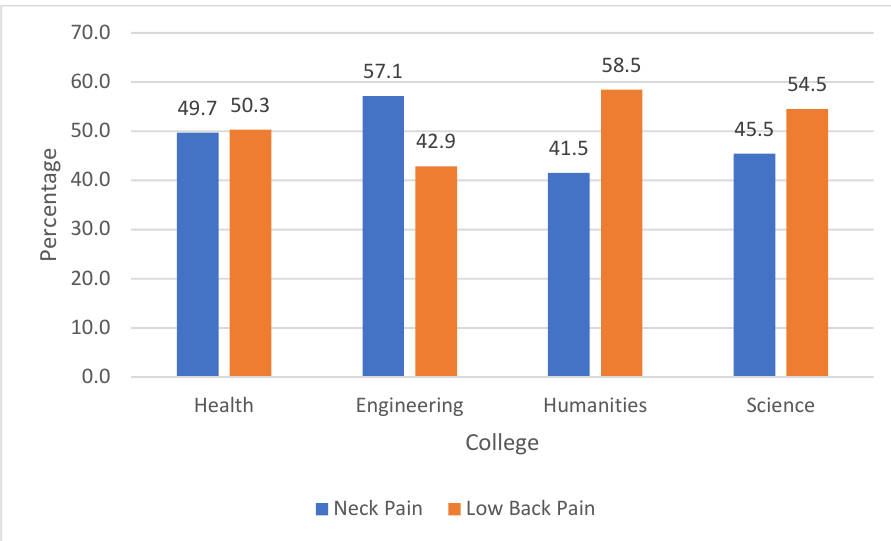
Figure 2. Prevalence of MSKP among university colleges last 7 days.